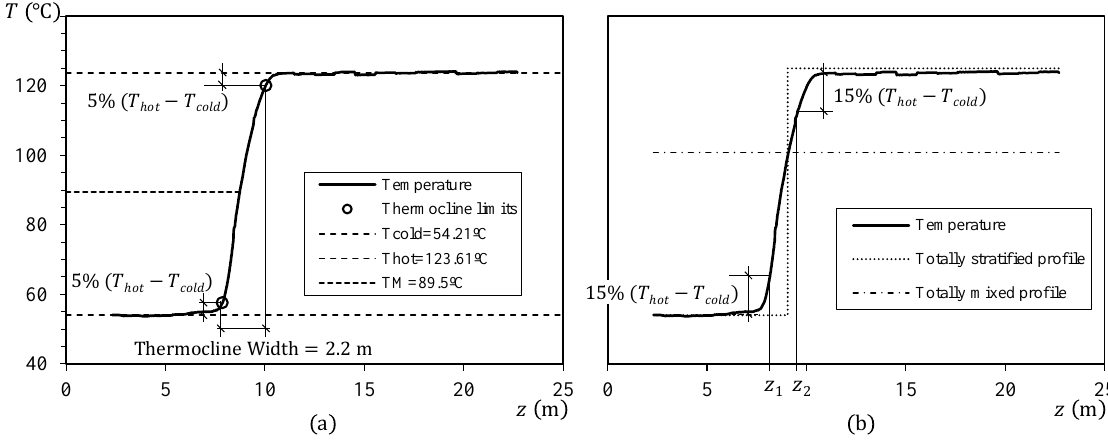
Figure 6. Example of determination from temperature profile of: ( a ) thermocline width; ( b ) heights z 1 , z 2 for First Law index I 1 L , totally mixed and totally stratified profiles for Second Law index I 2 L